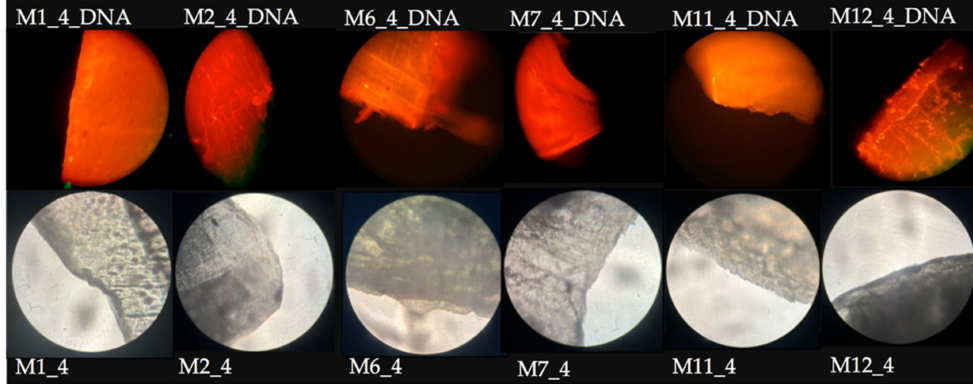
Figure 9. Fluorescence and optical photomicrographs of the composite supports before and after the contamination and ethidium bromide staining